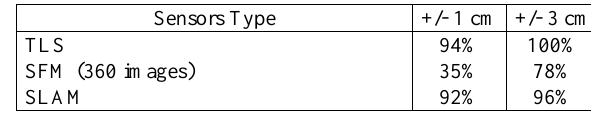
Table 2 . Percentage of points matching the plane identified by the TLS scan in the given